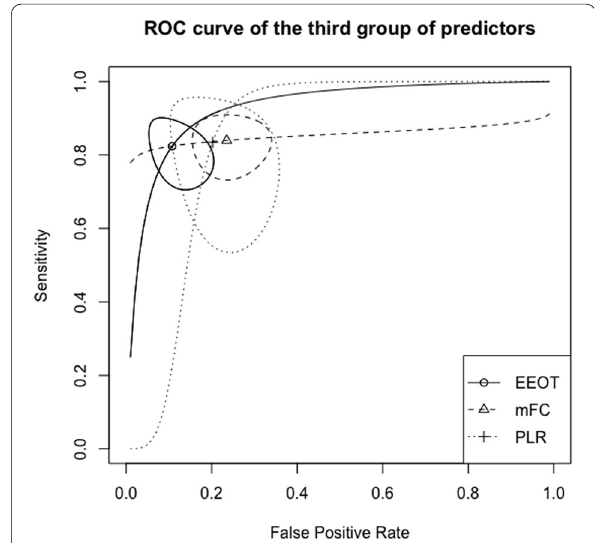
Fig. 4 Summary ROC curve for the third group of predictors of fluid responsiveness. EEOT, end‑expiratory occlusion test; m‑FC, mini‑fluid challenge; PLR, passive leg raising. Closed curve: 95% confidence region